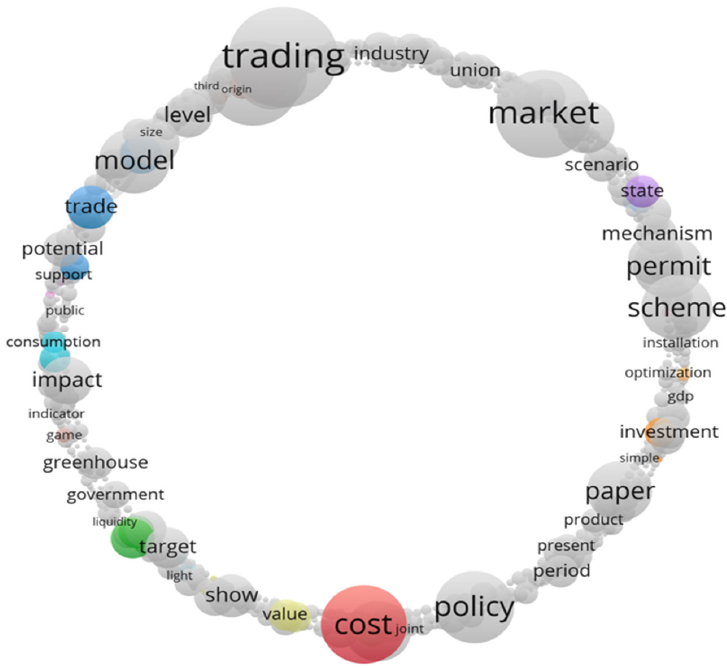
Figure 7. Words that appear more than ten times in the abstracts.